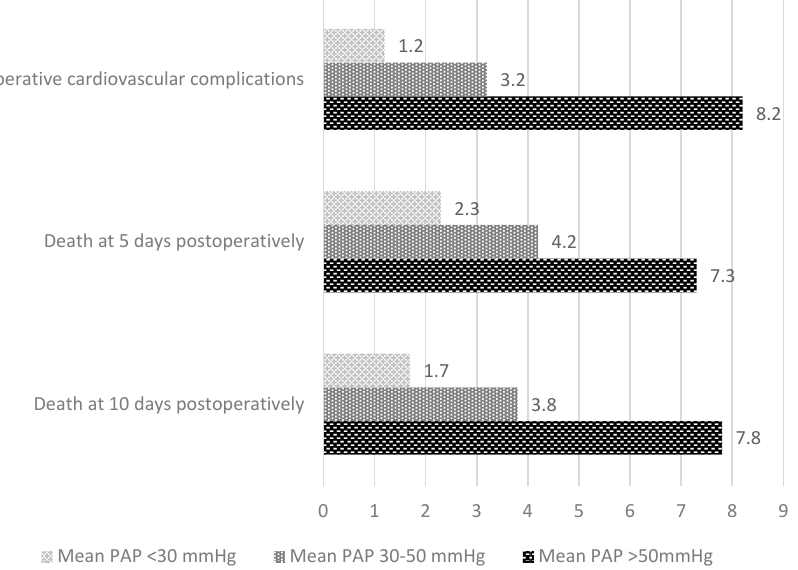
Figure 1. Relative risk for the occurrence of pulmonary hypertension in patients with aortic stenosis. The presence of severe PHT increased the early postoperative risk of death by 9.8- fold, regardless of the presence of other known parameters that increased mortality rate in these patients. In Figure 2, the relative risks associated with death at 5 and 10 days postoperatively are shown along with the appearance of postoperative cardiovascular complications, presented distinctly depending on the PAP value.